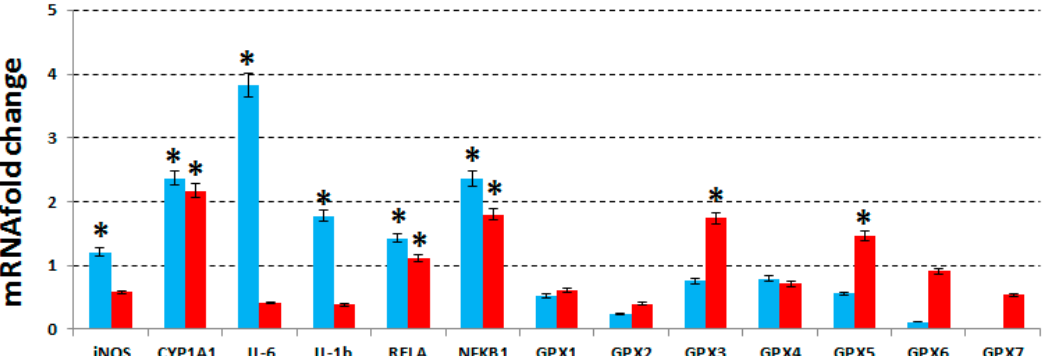
Figure 4. RT-qPCR analysis. We show the fold changes evaluated as ratio between the expression levels of 13 genes in two breast cancer cell lines, MCF7 ( cyan ) and MDA-MB231 ( red ), treated with 63 g and 64.5 g of phenolic extract from FS oil, compared to those in the untreated cells. We report the fold changes as mean value ± standard deviation. The statistically significant differences between treated and untreated samples are indicated by *.